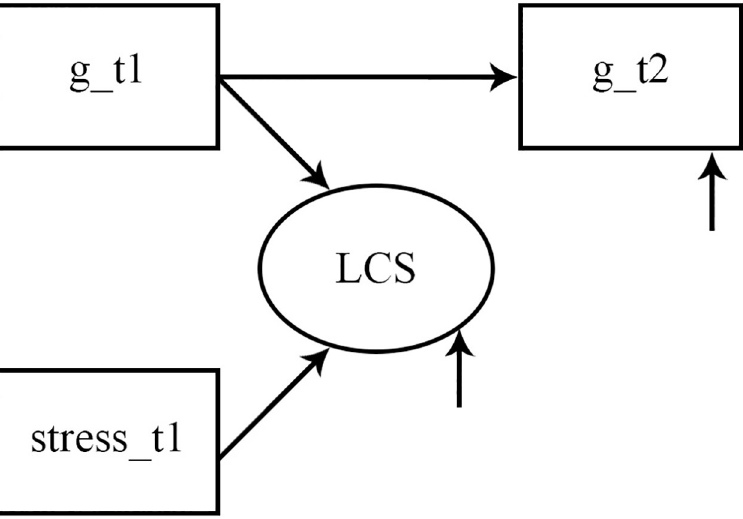
Fig 3. Latent change score structure equation models in Study 2. LCS = Latent change score. g_t1 = General Intelligence at the first measurement point. g_t2 = General Intelligence at the second measurement